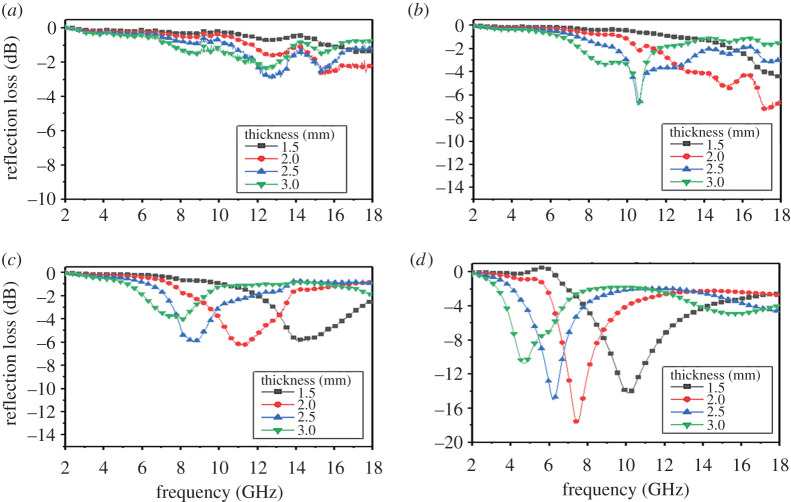
RL curves of MoSi2 ceramic with filler loading ratios of (a) 15 vol%, (b) 20 vol%, (c) 25 vol% and (d) 30 vol%.